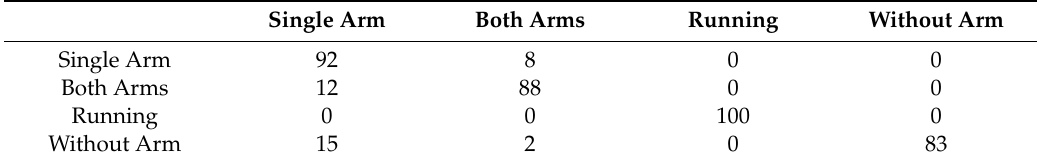
Table 3. Confusion matrix results of Multiwindow Adaptive S-method.